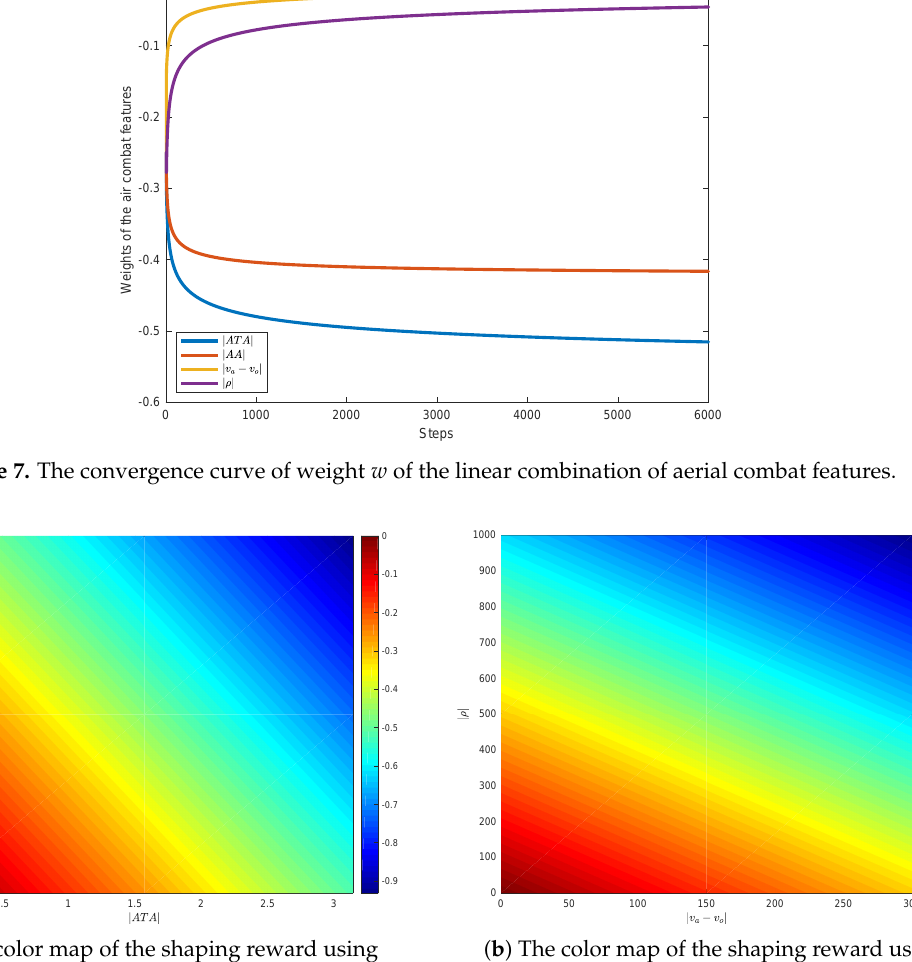
( b ) The color map of the shaping reward using | ρ | and | v a − v o | features